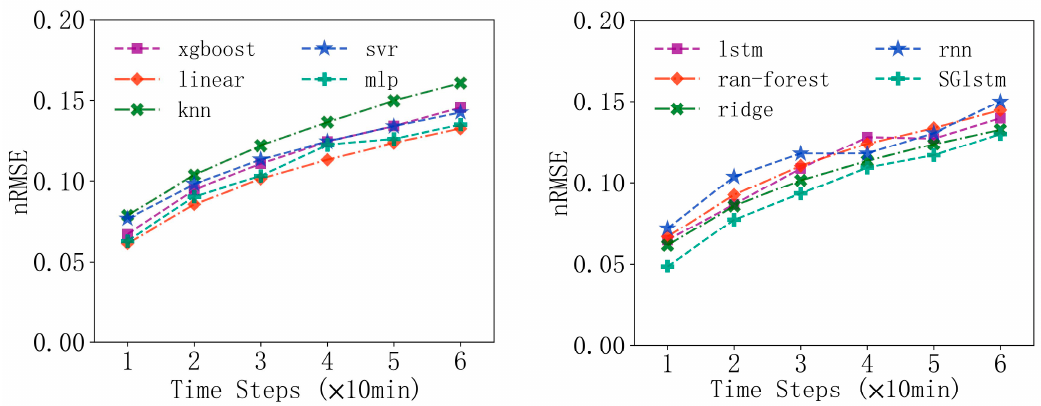
Figure 17. Error comparison chart of multi ‐ step forecast. Table 4. Performance comparison of different models for forward multi ‐ step power prediction.